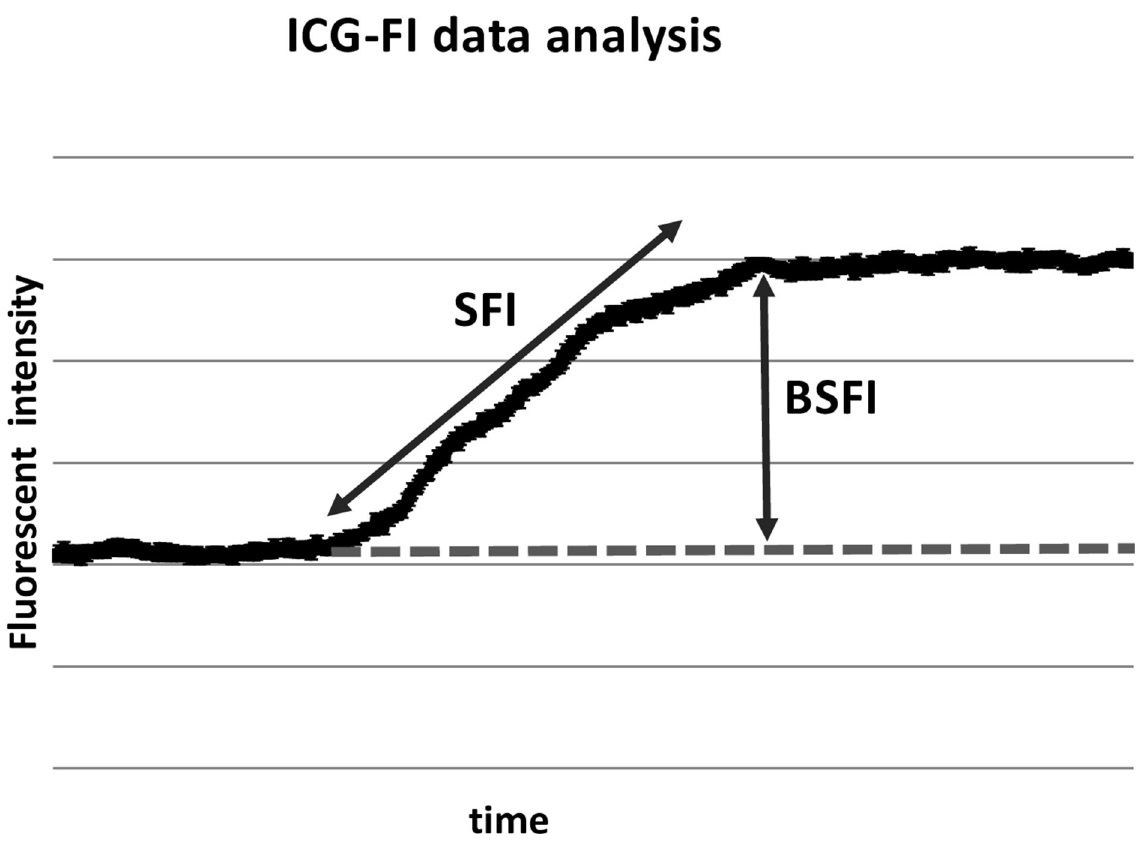
Fig 3. Technique of quantification. ICG-FI data is analyzed in the corresponding fluorescent intensity curve of each ROI. ICG-FI: Indocyanine green fluorescent imaging; ROI: region of interest; BSFI: Backround substracted fluorescent intensity; SFI: Slope of fluorescent